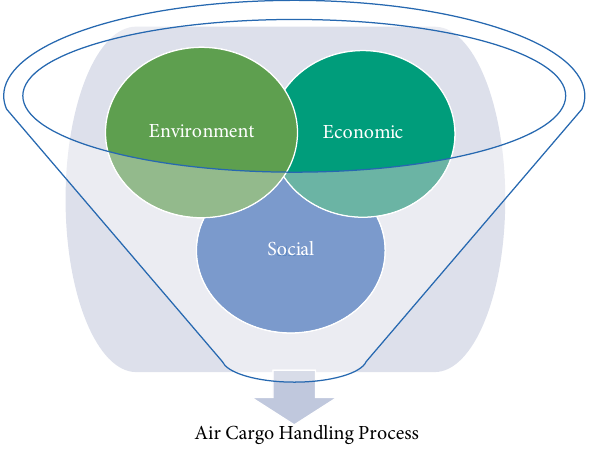
Figure 8: Air Cargo Handling Process sustainability components. Figure 7: Air Cargo Handling Process sustainability